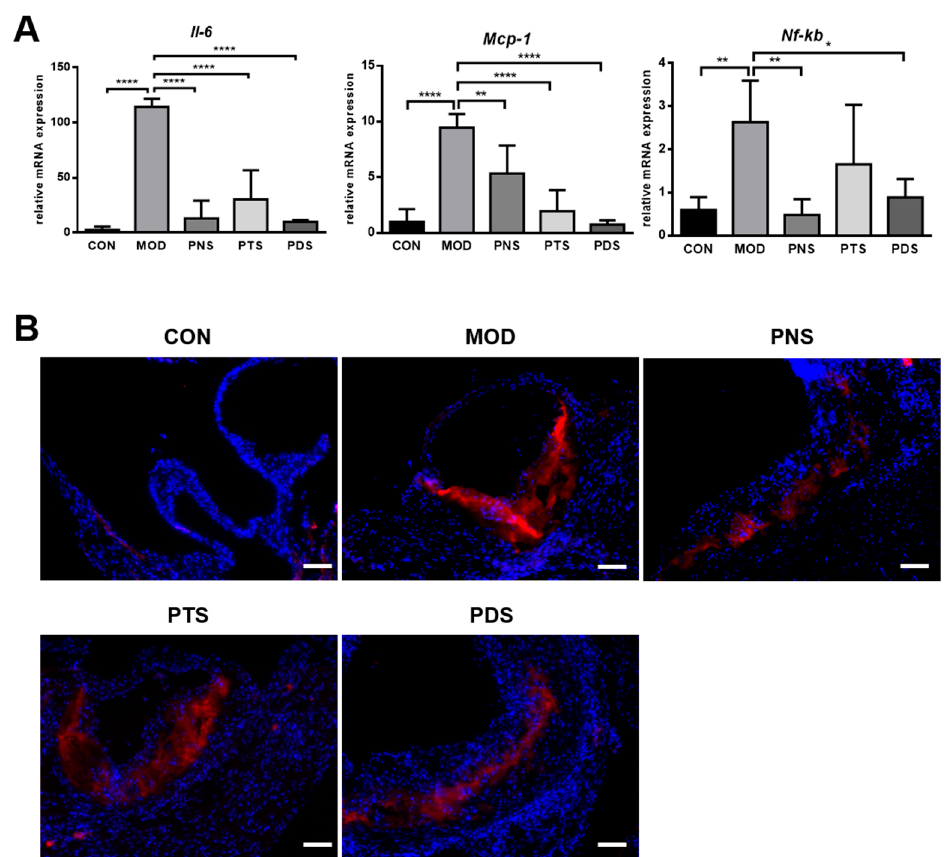
Figure 8. The transcriptional expression of Il-6, Mcp-1 , and Nf- κ b in the entire aorta tissue (A) , and the representative immunofluorescent staining of p65 (red) in the frozen section of the aortic sinus (B). Data in qPCR were normalized to the CON group (n = 5–6). *, p < 0.05; **, p < 0.01; ****, p < 0.0001. Scale bar, 100 μ m; nuclei were stained with DAPI (blue).